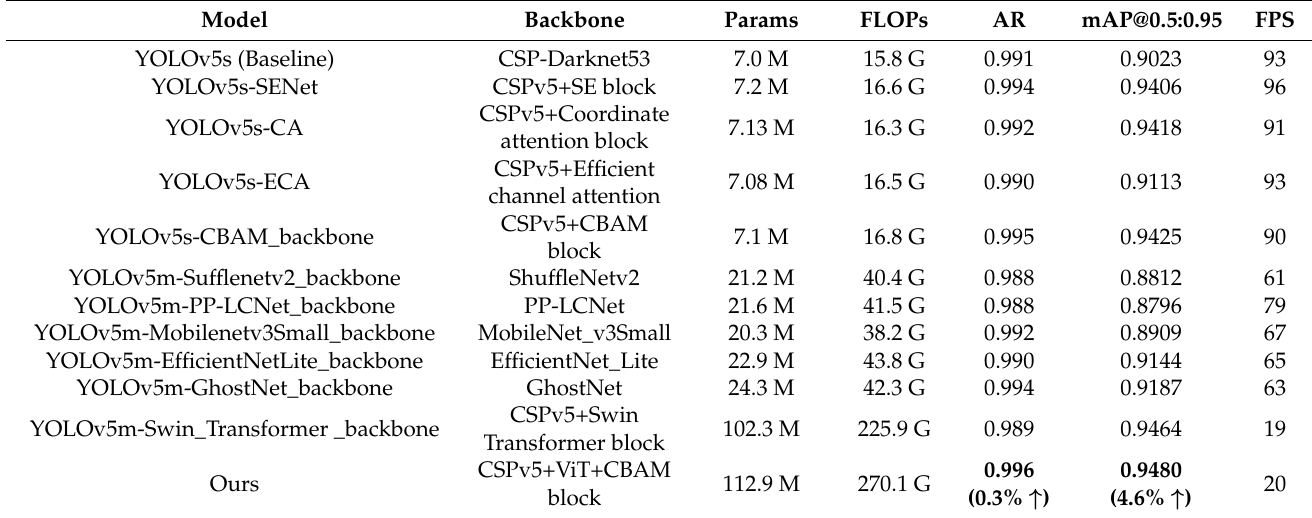
Table 2. Verification results under different backbone components (Stage one).